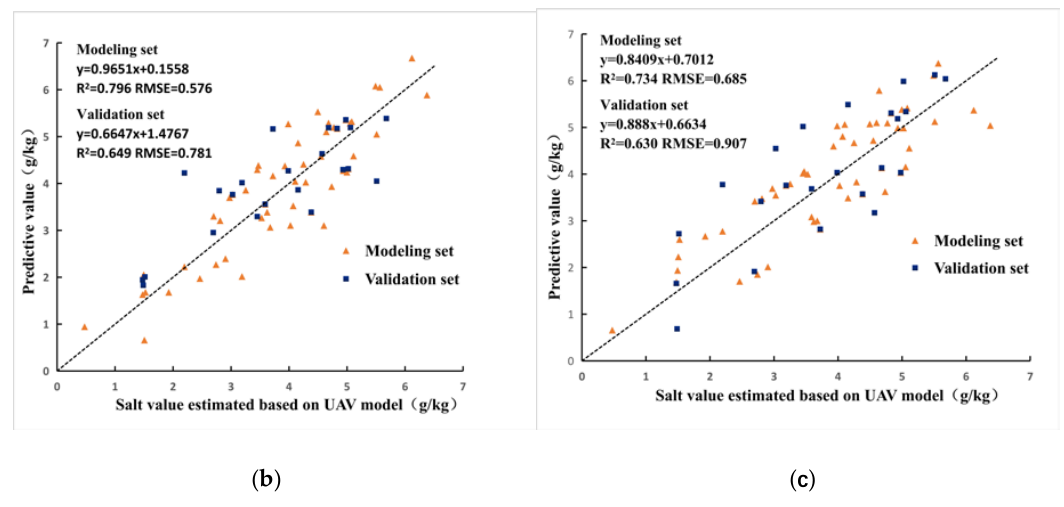
Figure 5. Accuracy of the three collaborative inversion models, ( a ) RF model, ( b ) SVM model, and ( c ) BPNN model.